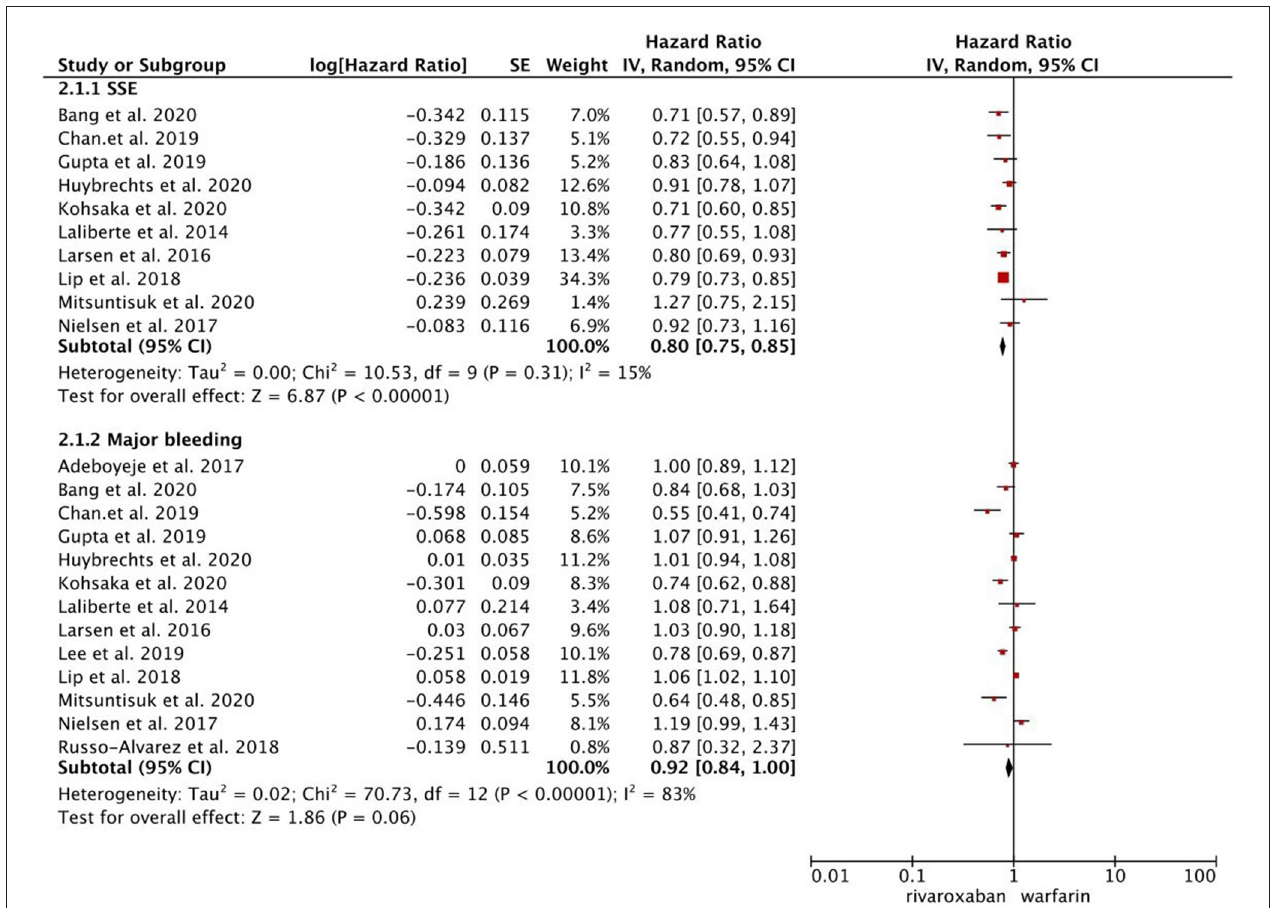
FIGURE 2 | Comparing the primary outcomes including SSE and MB of rivaroxaban vs. warfarin. SSE, stroke or systemic embolism; MB, major bleeding; HR, hazard ratio; CI, confidence interval; SE, standard error; IV, inverse of the